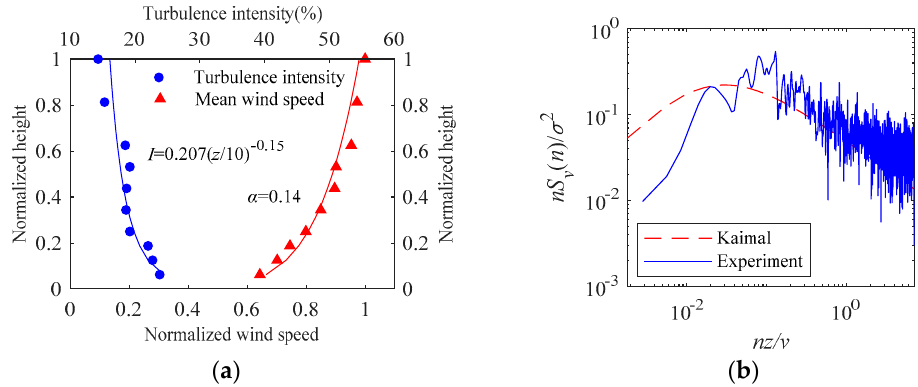
Figure 12. Wind environment simulation. ( a ) Vertical profiles of horizontal wind speed and turbulence; ( b ) Wind power spectrum at height of 0.4 m.